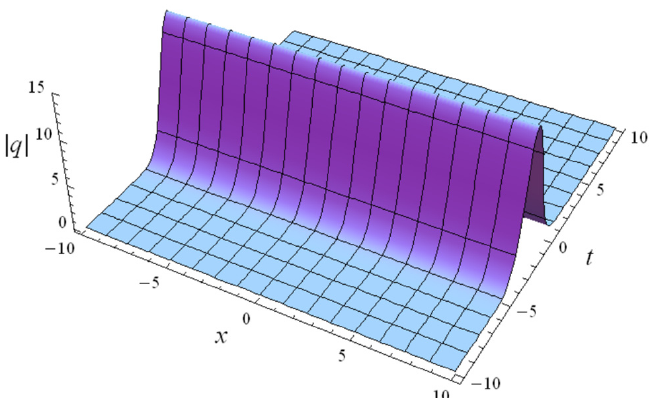
Figure 2. Space–time dynamical evolution of solution (115) with κ 1 ( 0 ) = 0.5, κ 1 ( 0 ) = 0.3, c 1 ( 0 ) = 1,